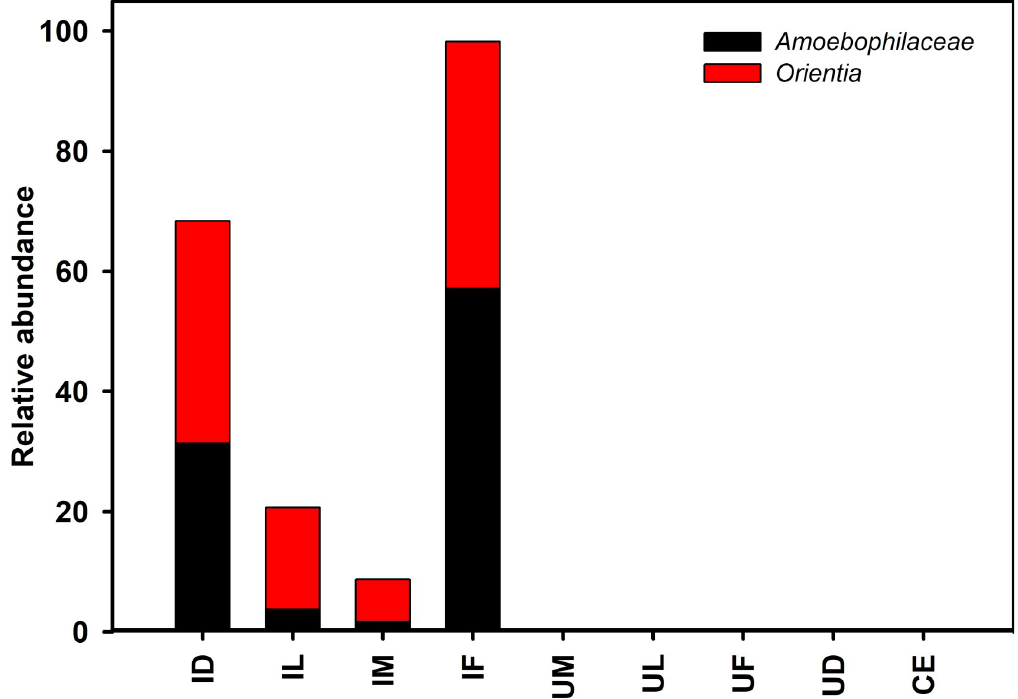
Fig 5. Relative abundance of Orientia and Amoebophilaceae OTUs as average across different groups. Abbreviations: ID, infected deutonymphs; IF, infected females; IL, infected larvae; ILPCRN, infected larvae PCR negative; IM, infected males; IMPCRN, infected males PCR negative; UD, uninfected deutonymphs; UF, uninfected females; UL, uninfected larvae, UM, uninfected males, CE, Collembola eggs.